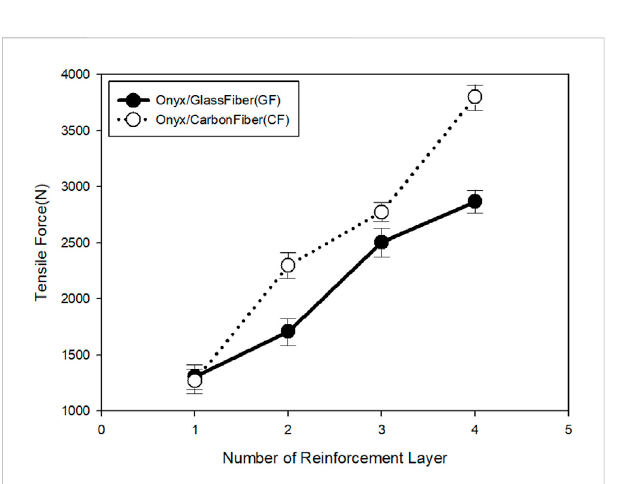
FIGURE 3 Tensileforceaccordingtothetypeofreinforcementandnumber of layers.